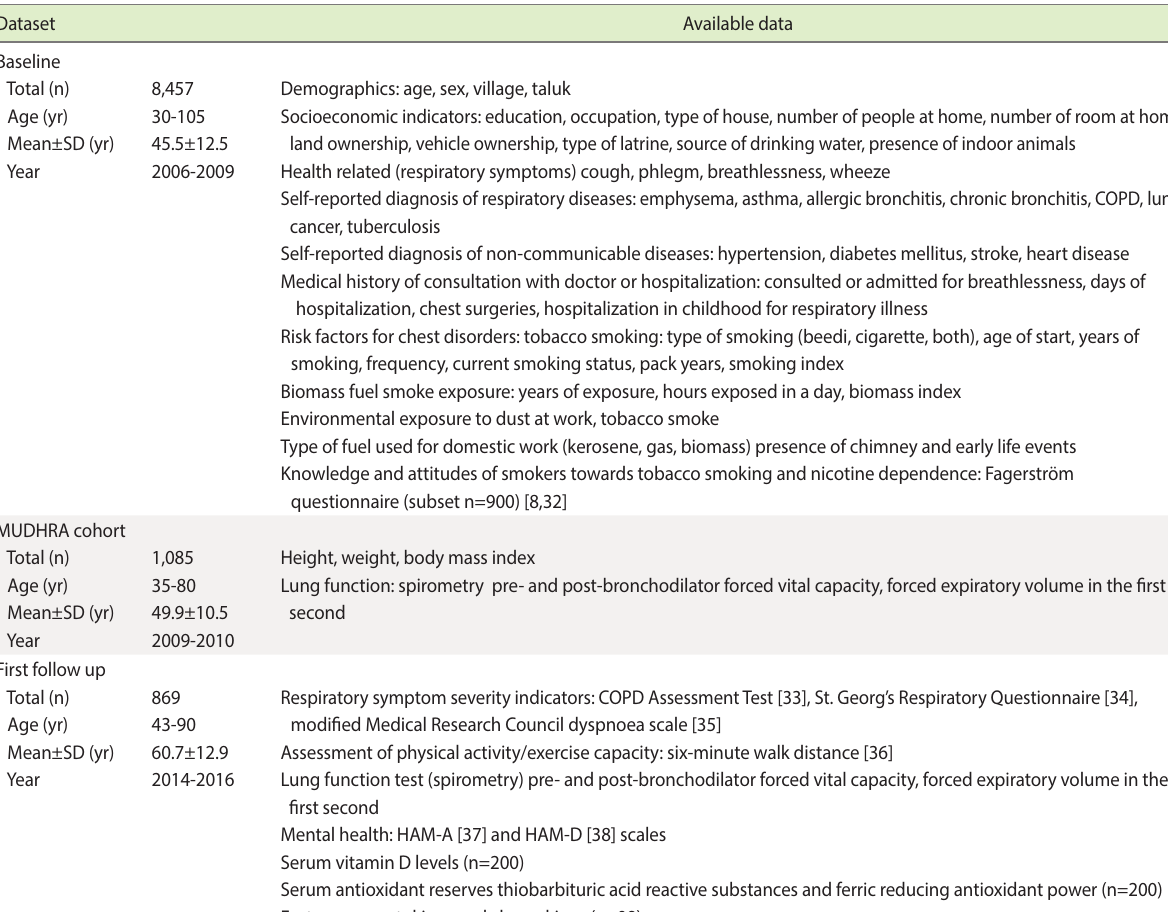
Table 1. The list of variables collected during the different phases of the study